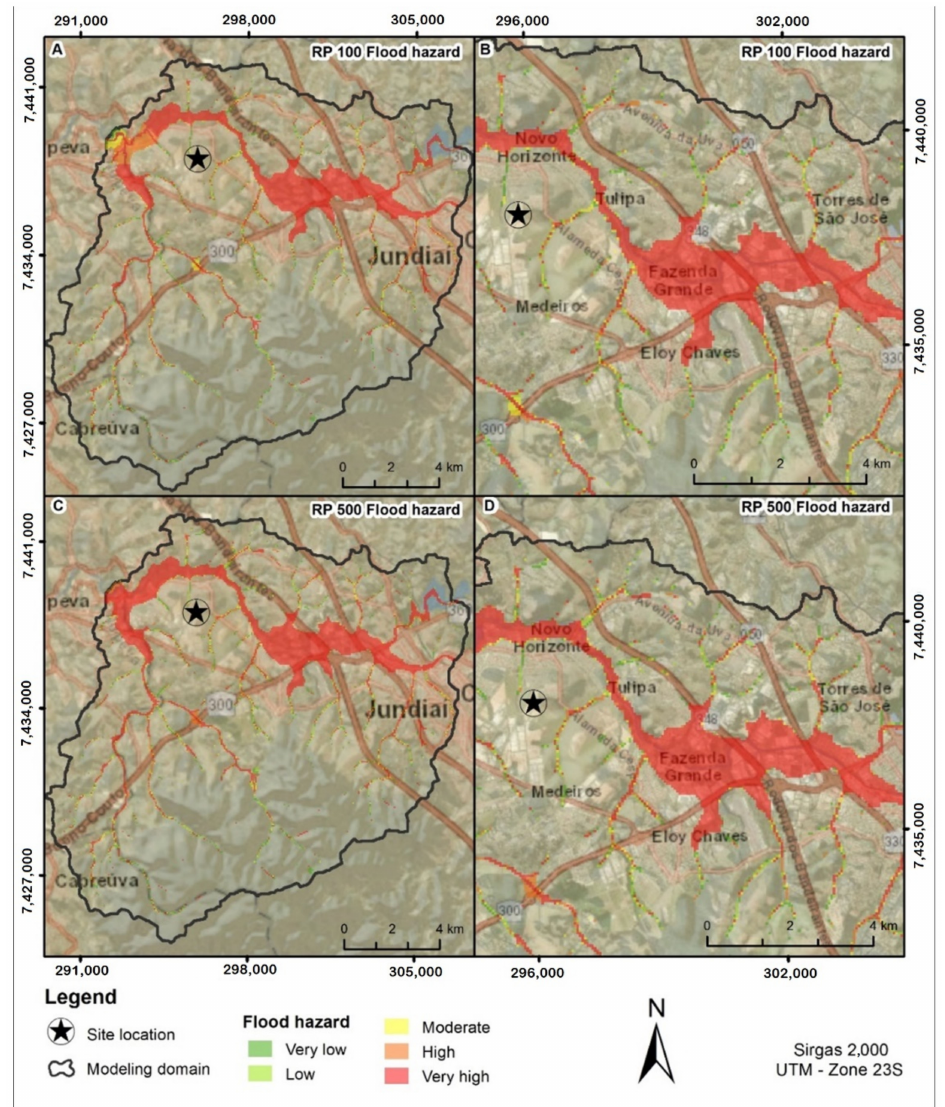
Figure 12. Mapping of flood hazard-industrial park. ( A ) 100 years’ recurrence time storm. ( B ) 100 years’ recurrence time storm zoomed to industrial park site. ( C ) 500 years’ recurrence time storm. ( D ) 500 years’ recurrence time storm zoomed to industrial park